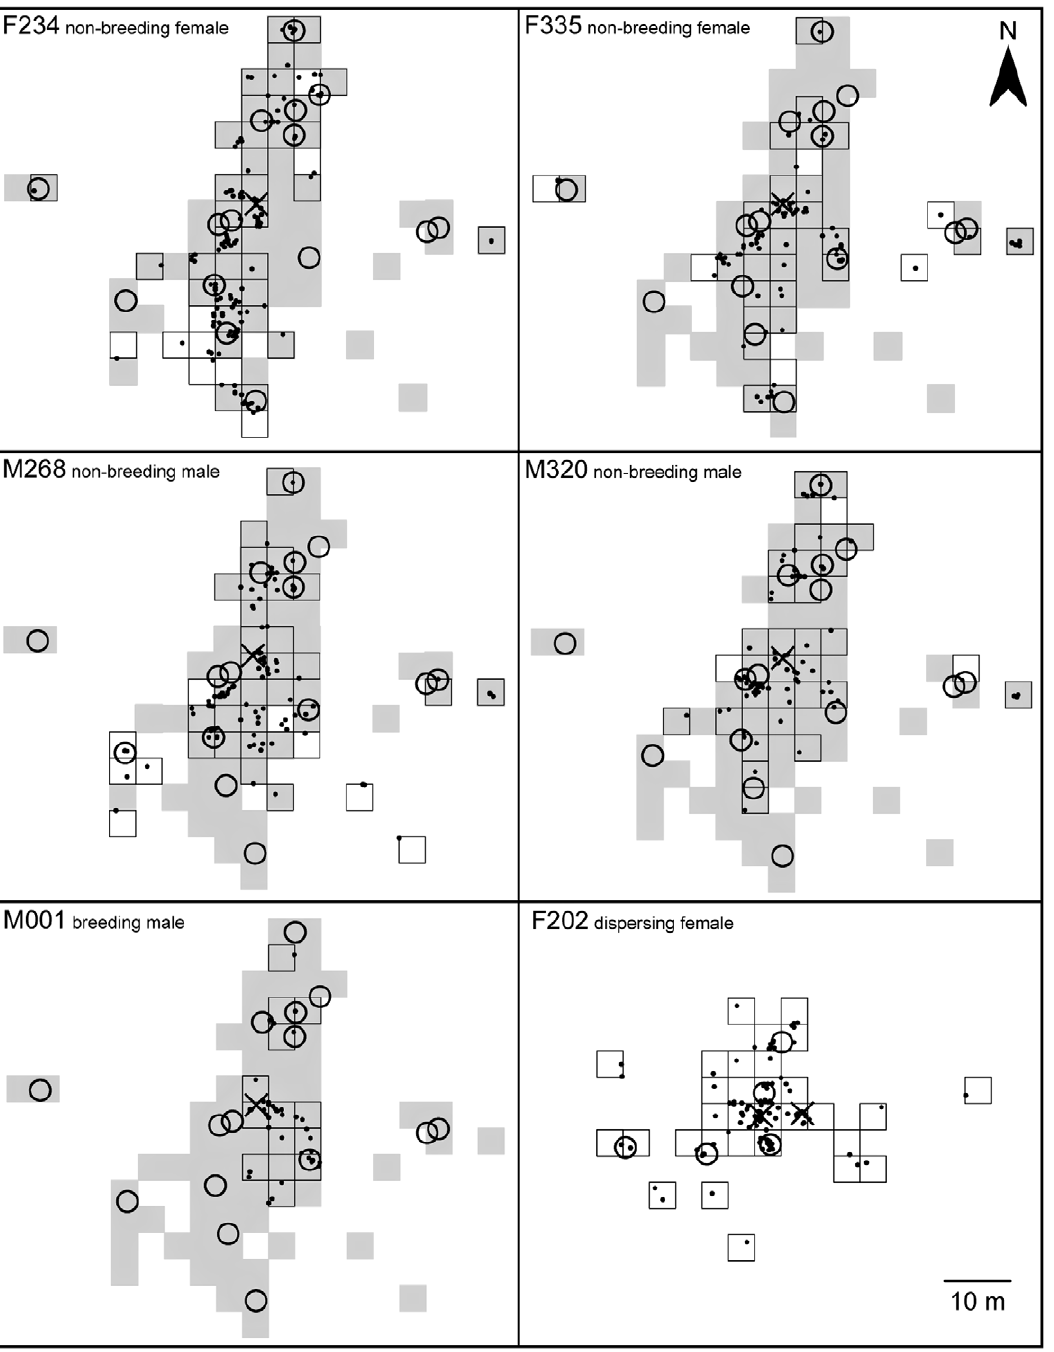
Figure 1. Home ranges of the radio-tracked giant mole-rats. Squares with a black outline represent the GC home range; white squares represent the exclusive home range of a particular individual; the grey area represents GCs of the whole family HR except the GCs already depicted. Dots represent radio-fixes, crosses mark nests and open circles show food sites.